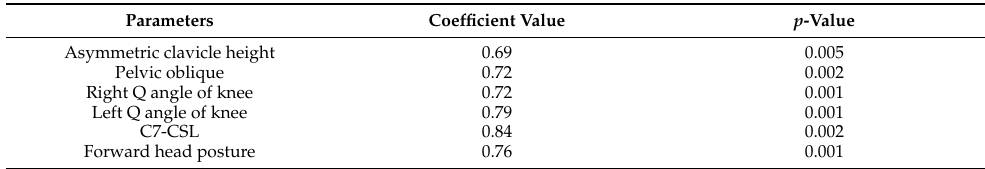
Table 3. Intra-rater reliability of